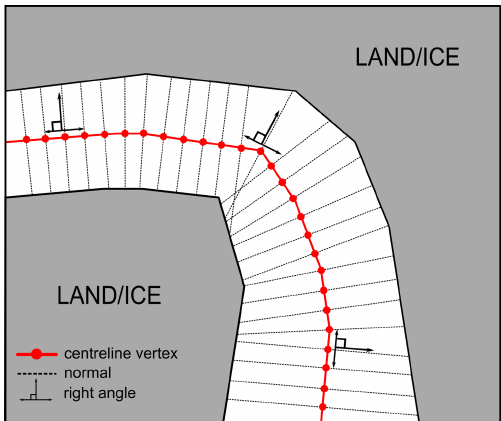
Figure 6. For a given centreline vertex, new points (black dashed lines) are created normal to the centreline trajectory (solid red line), up to the sides of the channel as defined by the land–ocean mask (Howat et al., 2014; Morlighem et al., 2014). Normal angles are calculated relative to the vector between the neighbouring points of a given